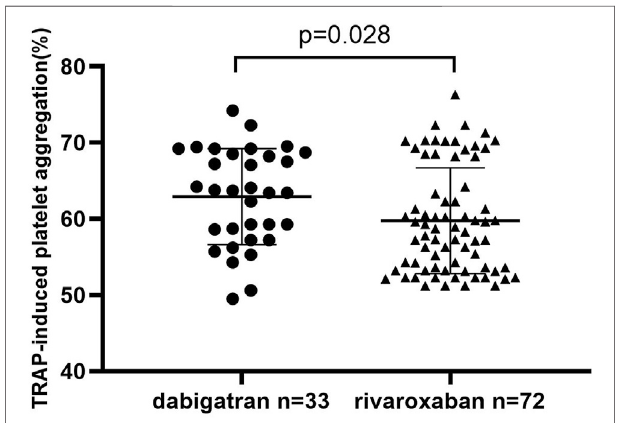
FIGURE 2 | TRAP-induced platelet aggregation: a comparison between dabigatran and rivaroxaban.